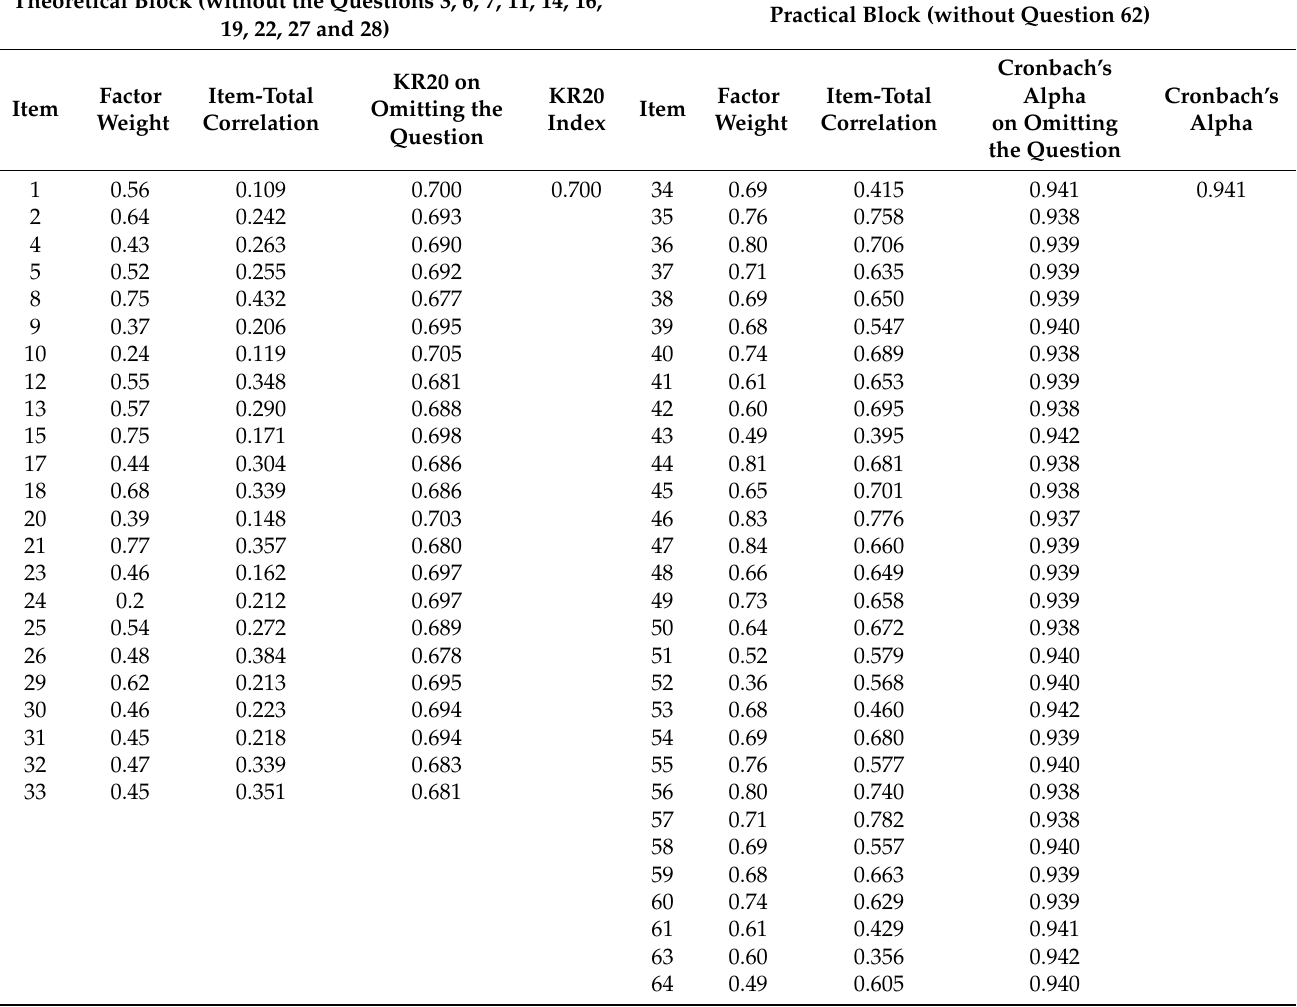
Table 3. Factors weighting of the items in the model and final block reliability